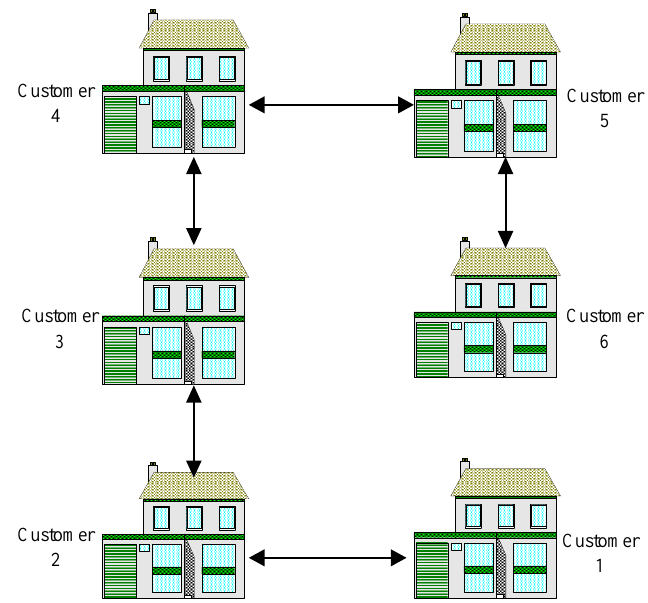
Figure 12. Communication topology of the chain connection.